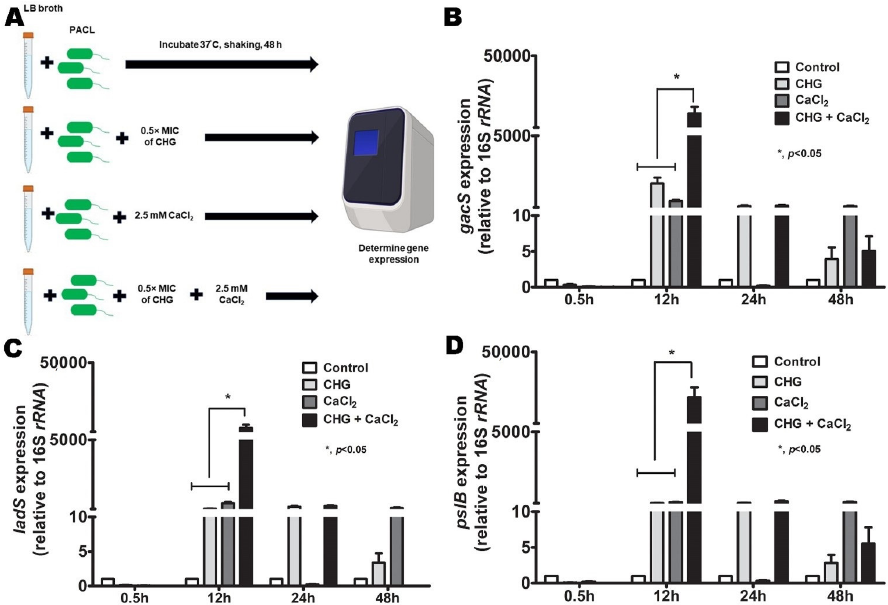
Figure 7. LadS/GacS regulation system in the presence of Ca 2+ . The diagram of the experiments that P. aeruginosa parent strain (PACL) treated with Chlorhexidine (CHG) alone or in the combination with CaCl 2 before an evaluation of gene expression by qRT-PCR ( A ) of gacS ( B ), ladS ( C ), and pslB ( D ) are demonstrated (the experiments were performed in independent triplicate). Mean ± SEM are presented with the one-way ANOVA followed by Tukey’s analysis (*, p ˂ 0.05 considered statisti- cally significant). Because the psl -mediated aggregation in P. aeruginosa plays a critical role in chronic wound infection [37,38] which consists of several cell types, including fibroblasts and macrophages, the responses of these cells against both strains of P. aeruginosa are interest- ing. The difference between the fibroblast responses against sessile bacteria (bacteria with biofilms) versus planktonic form (bacteria without biofilms) within PACL parent strain or C_PACL was not obviously different. Accordingly, there was the upregulated TLR-4 but downregulated IL-6 without the difference in other genes nor cytokine responses in sessile PACL compared with planktonic PACL (Figure 8A–M). Meanwhile, there was a higher TLR-4 and TNF- α expression but lower IL-6, IL-8, TGF- β , and GM-CSF in sessile C_PACL when compared with the activation by planktonic C_PACL (Figure 8A–M). Thus, the dif- ference of the activation by sessile versus planktonic PACL or sessile versus planktonic C_PACL toward fibroblasts were not obvious. In comparison with planktonic PACL, the planktonic C_PACL upregulated IL-8, TGF- β , GM-CSF, TLR-2, TLR-5 , and TLR-6 but downregulated IL-6 without the alteration in other parameters in fibroblasts (Figure 8A– M) implied a mildly prominent pro-inflammation of planktonic C_PACL over planktonic PACL. In contrast, the sessile C_PACL down-regulated IL-6, IL-8, TGF- β , and GM-CSF when compared with sessile PACL (Figure 8A–M) suggested a less inflammatory impact of C_PACL biofilms on fibroblasts possibly due to the reduced biofilm biomass in sessile